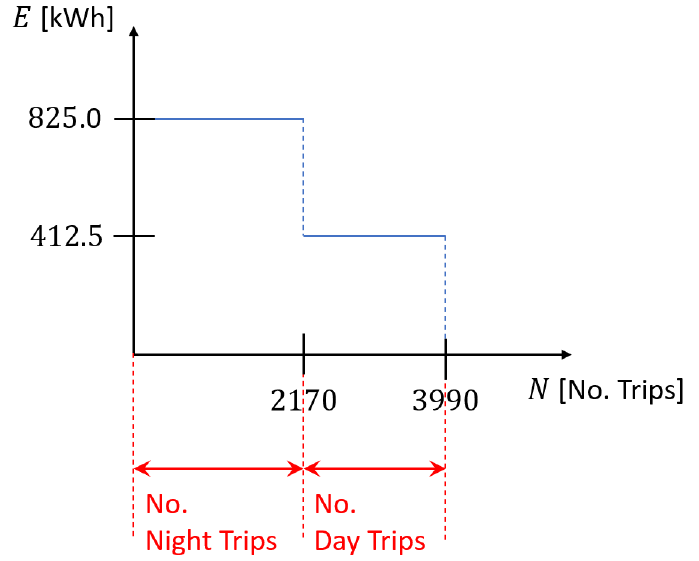
Figure 3. The energy distribution diagram for each